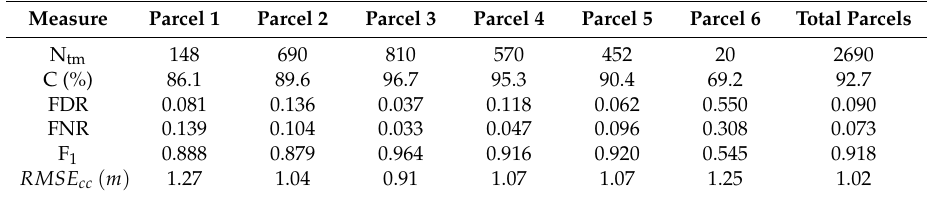
Table 6. Data quality measures results for